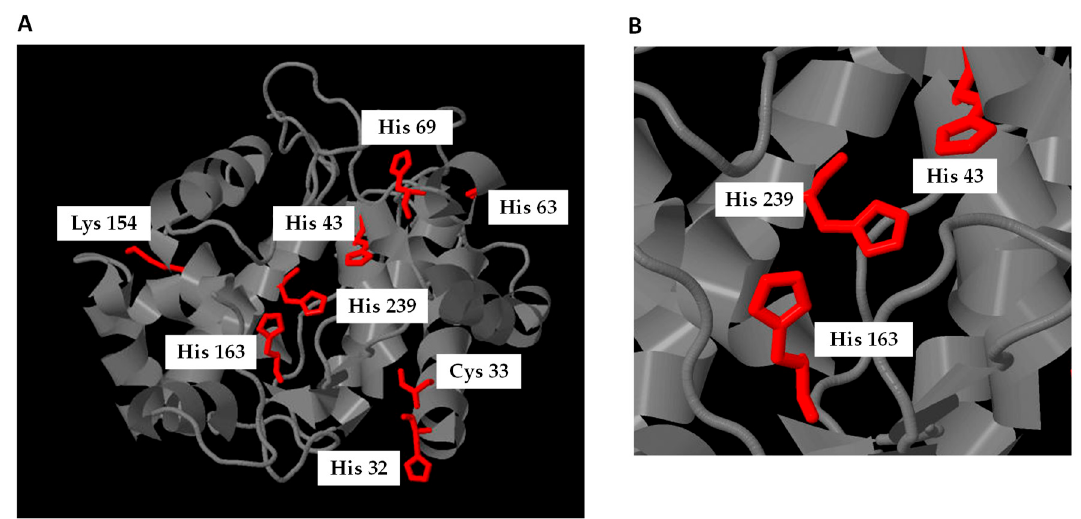
Figure 7. ( A ) In silico molecular model of cytosolic recombinant APX and localization of nitroalkylated residues. ( B ) Zoomed in illustration of the in silico molecular model where nitroalkylated histidines 43 and 163 located in the active site and in a metal-binding site, respectively, are highlighted.